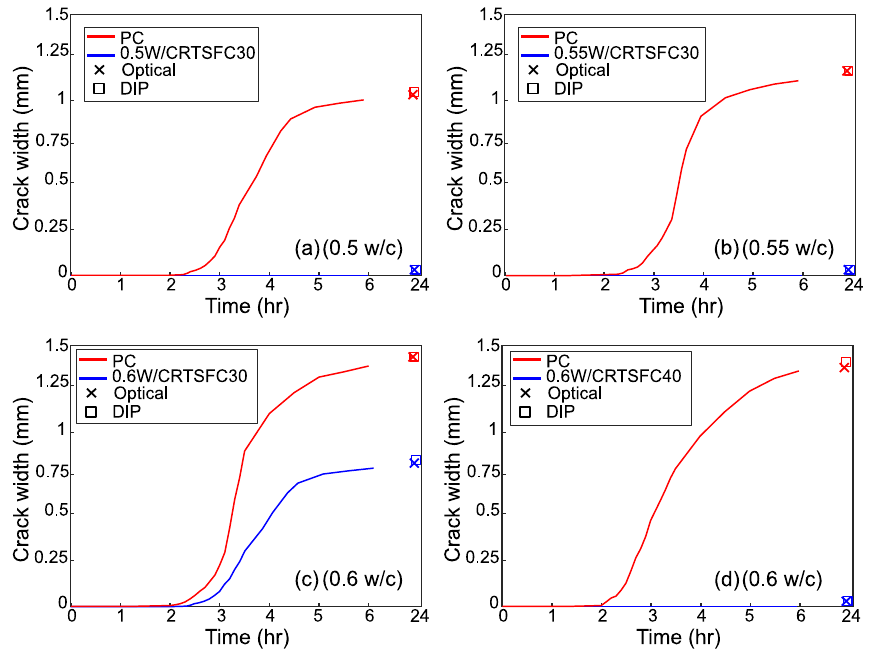
Figure 14. Crack evolution for the specimens manufactured using different w / c ratios.